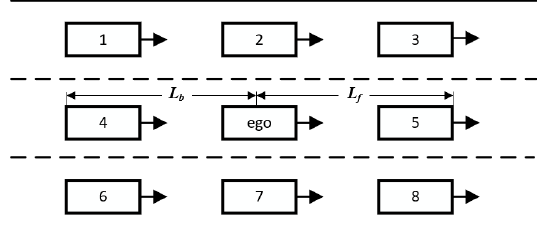
Figure 3. DOI based on distance [115].